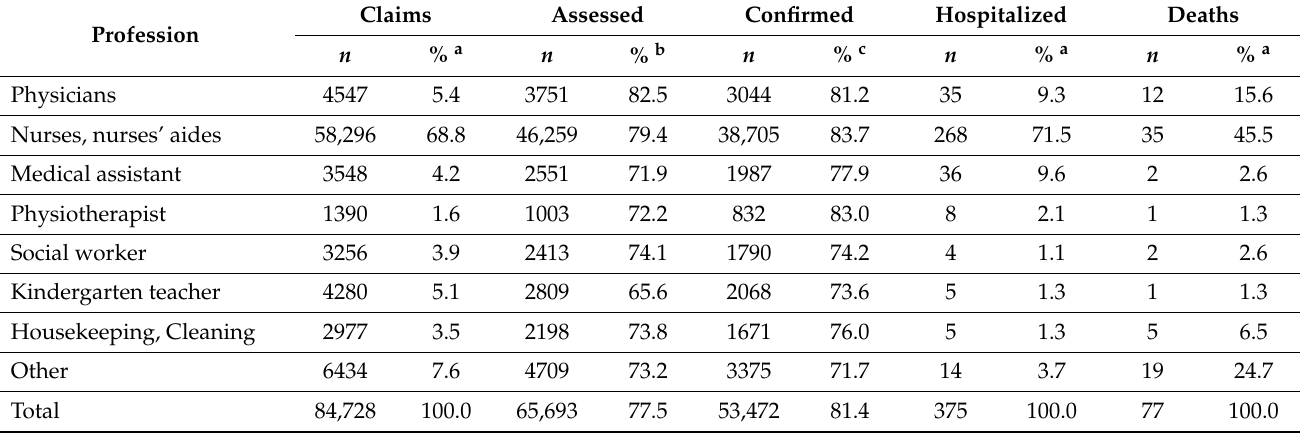
Most claims concern nurses and nurses’ aides (68.8%), followed by physicians (5.4%) (Table 3). Disregarding “Other professions”, the confirmation rate was lowest in kinder- garten teachers (73.6%) and highest in nurses and nurses’ aides (83.7%). Hospitalization most often concerns nurses and nurses’ aides (71.5%), followed by physicians (9.3%). The same is true for deaths resulting from COVID-19 (nurses and nurses’ aides 45.5%, physicians 15.6%). Table 3. COVID-19 cases reported to accident insurance provider BGW broken down by profession.